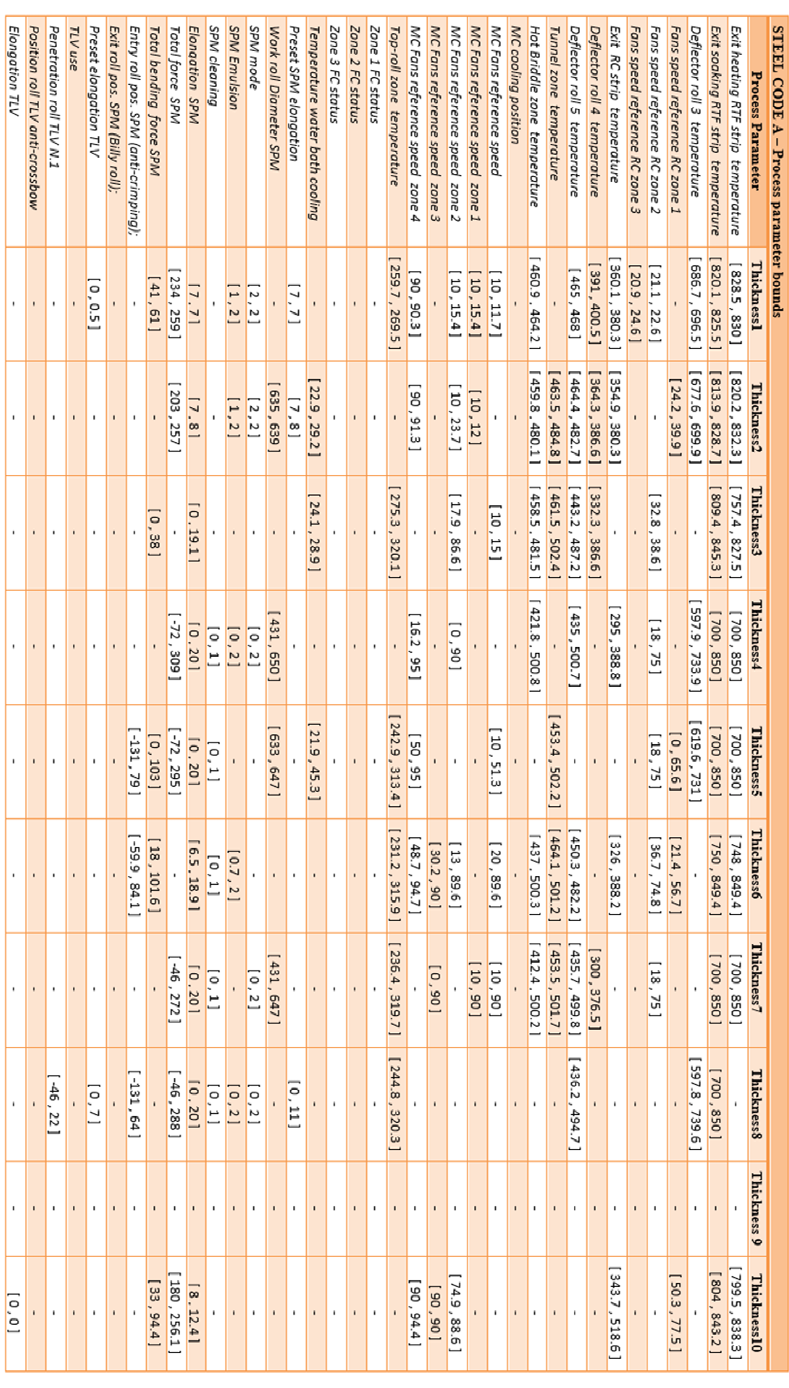
Figure A1. Process parameter bounds for Steel Code A by thickness range.